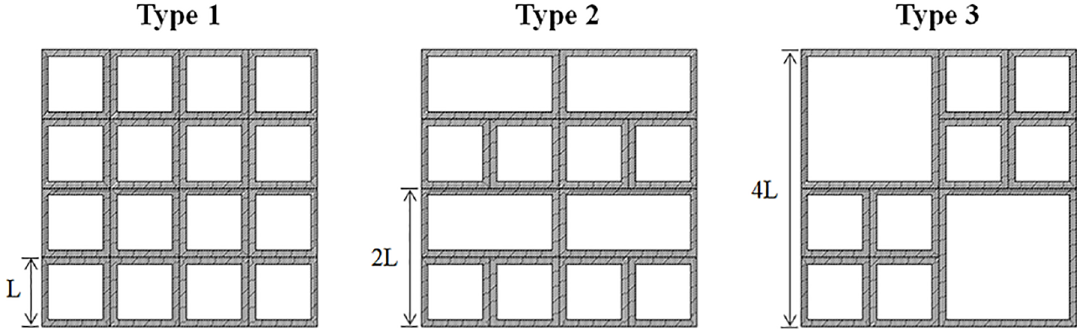
Figure 6. Top views of three nanostructure types.